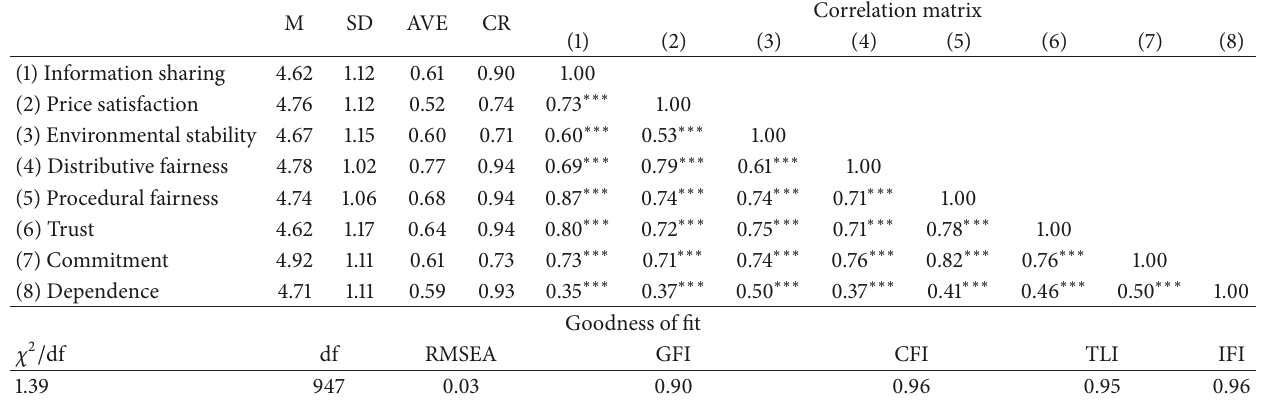
Table 2: Means, standard deviations, AVE, CR, correlation matrix, and goodness of fit.